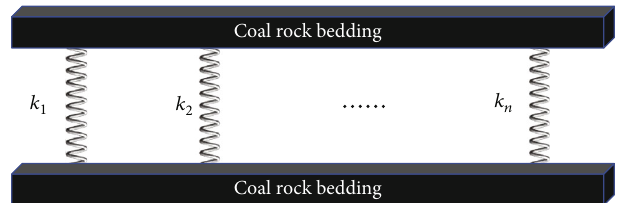
Figure 2: Vibration model of multi-degree-of-freedom coal.